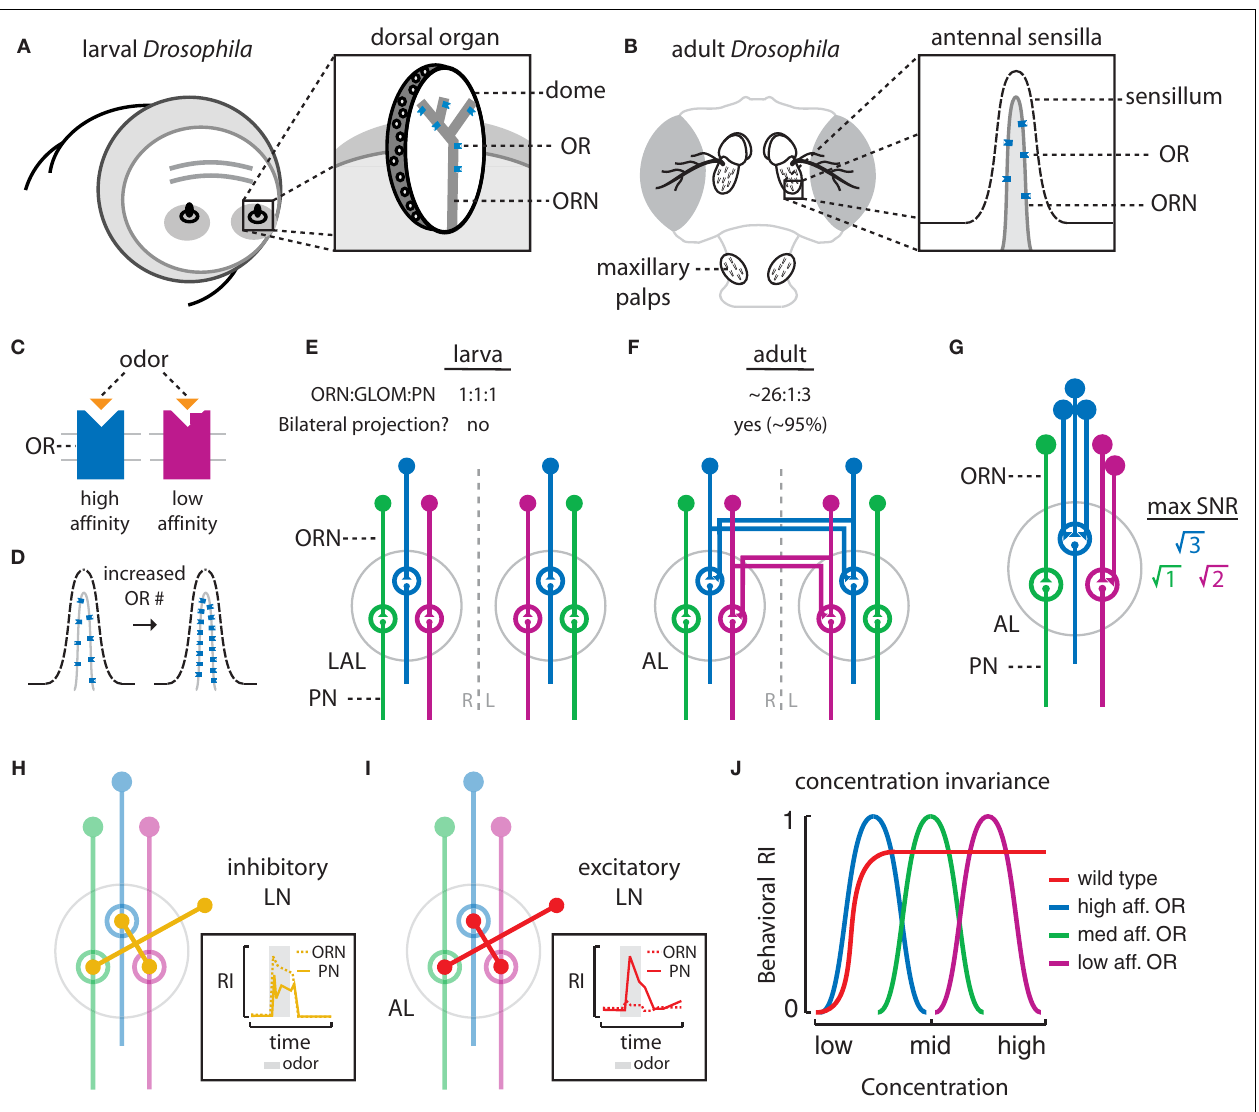
FIGURE 2 | Mechanisms of odor processing in the peripheral olfactory system of the larval and adult Drosophila . (A) The larval olfactory system is composed of two dorsal organs located at the tip of the head. Inset: Each dorsal organ is a central, multiporous “dome”. Odorant receptors (ORs) reside in the dendritic membranes of 21 olfactory receptor neurons (ORNs) which densely innervate the dome. (B) In adults, the 3rd antennal segments and maxillary palps are covered with olfactory sensilla. Inset: ORs reside in the dendritic membranes of ORNs housed within an individual porous sensillum. (C) The binding domains of ORs determine the specifi city and affi nity of an OR for specifi c odors. (D) Increasing the number of ORs in the ORN dendrites increases the number of available odor-binding sites, possibly enhancing ORN sensitivity. (E) Larval ORNs project ipsilaterally to discreet glomeruli within the larval antennal lobe (LAL) and synapse onto second-order olfactory projection neurons (PNs). In larvae, the ORN to glomerulus (GLOM) to PN ratio is 1:1:1. (F) Adult ORNs project bilaterally to discreet glomeruli within both the left and right antennal lobes (AL) and